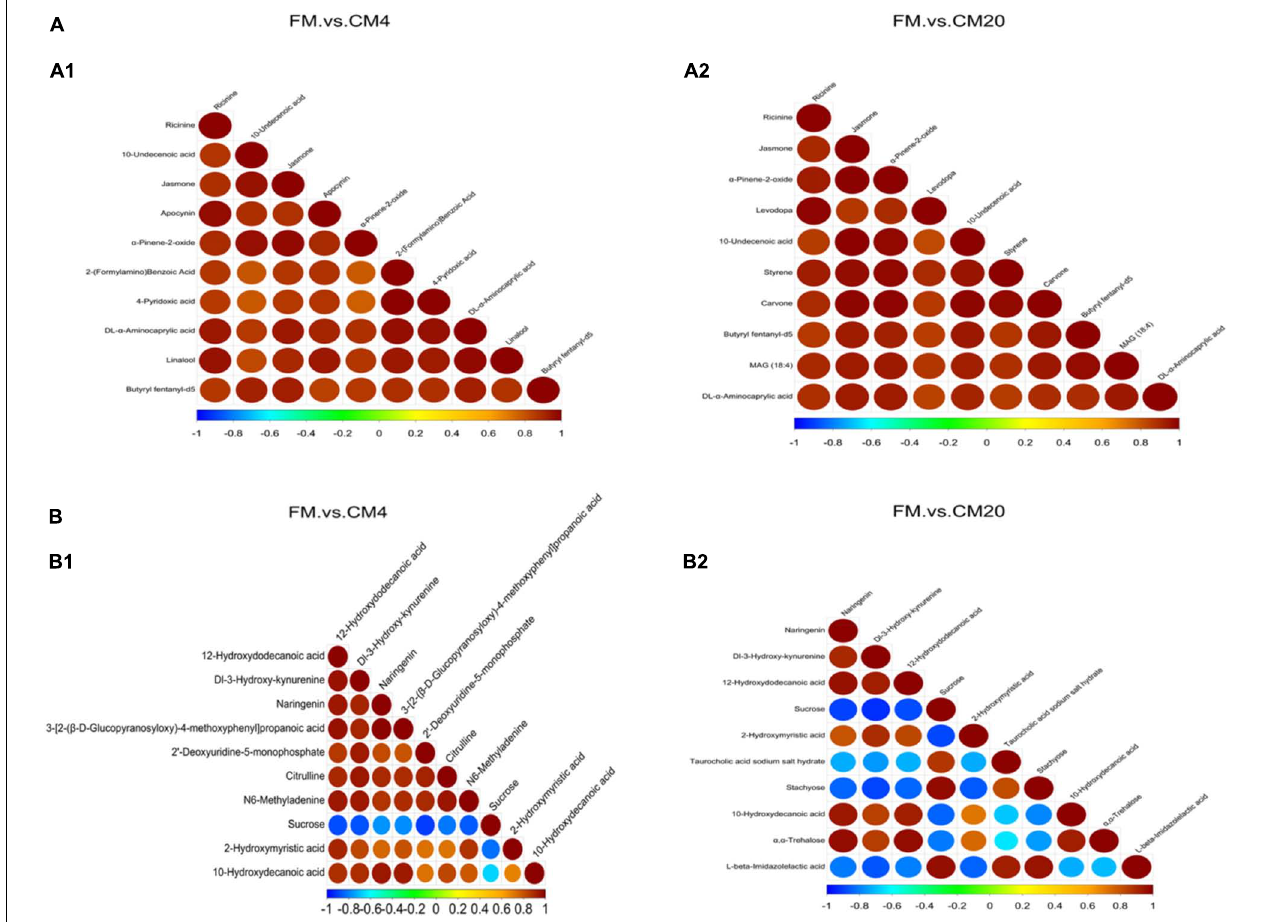
FIGURE 12 | The correlation analysis of the potential biomarkers between FM and CM4 groups and FM and CM20 groups in the positive (A1,A2) and negative (B1,B2) modes. Abbreviations are as defined in Figure 1 . n = 6.